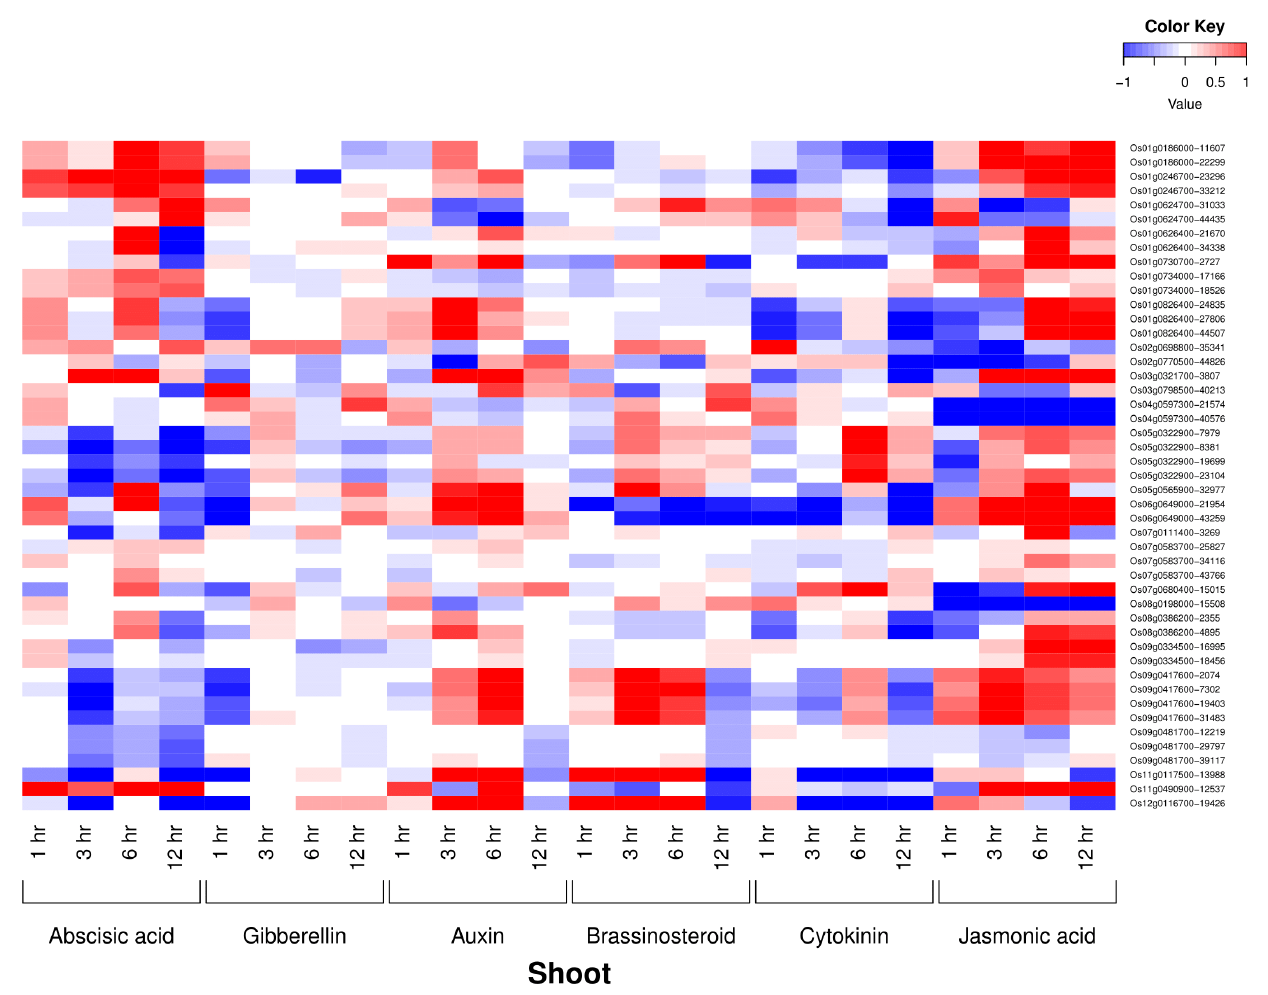
Figure 2. Heatmap representing the potential 26 AbSR— OsWRKY TF family members and their phytohormonal ex- pression pattern in the shoot which are differentially regulated across the entire growth in the field conditions. The red color indicates up-regulation, the blue color indicates down-regulation, and the white color indicates no expression. The color bar at the right side top represents the level of expression value, where − 1 and 1 represent the down- and up-regulation of AbS responsible OsWRKY TF family members.